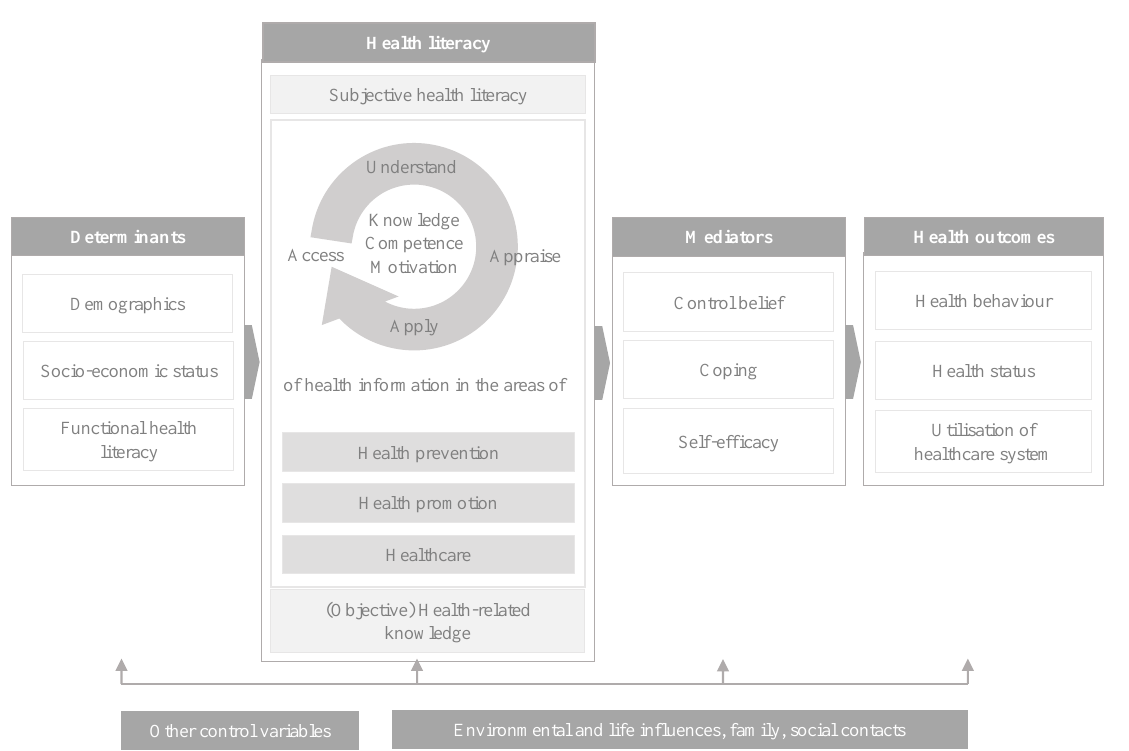
Figure 2. Conceptual framework adopted from Sørensen et al. [3], Schaeffer et al. [41], and Messer et al. [42] .